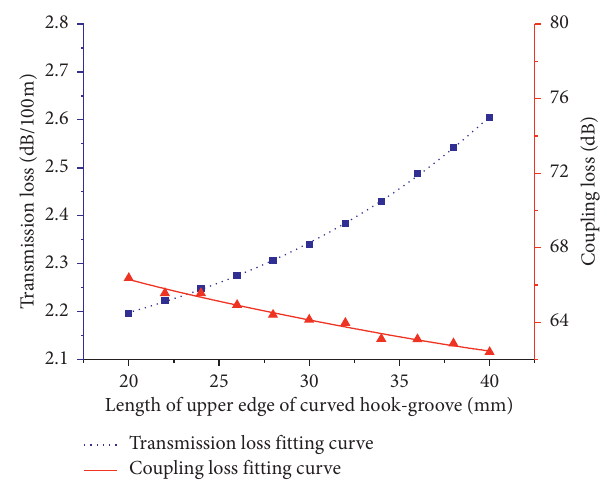
Figure 14: Effect of the length of the upper side of the curved hook- groove on the loss of leakage